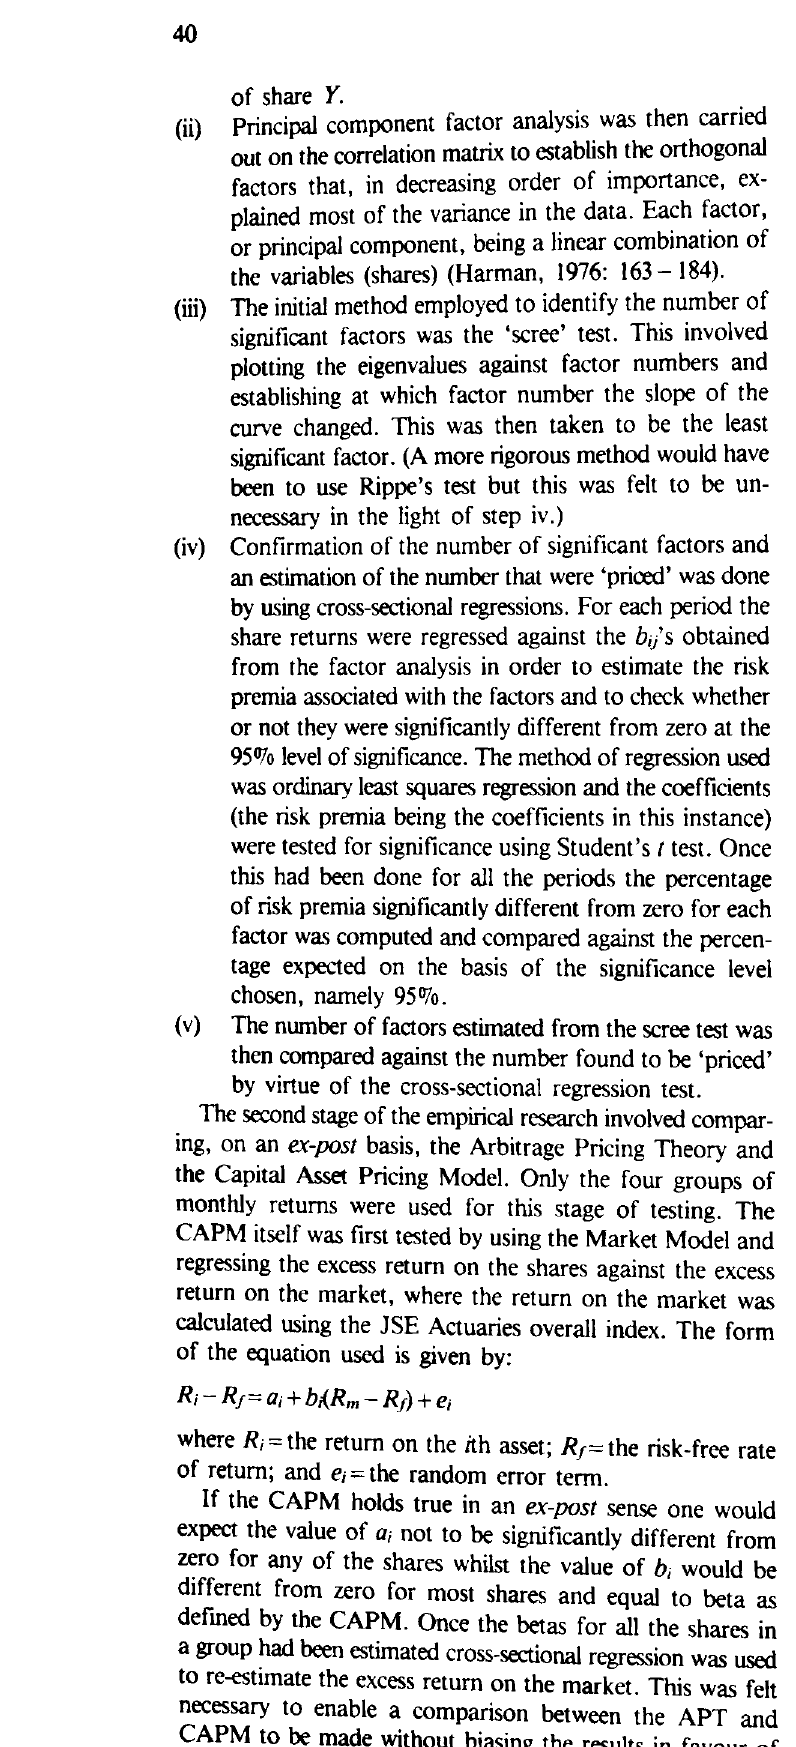
Monthly data - percentage of cross-sectiOII premia estimates significantly different from zero